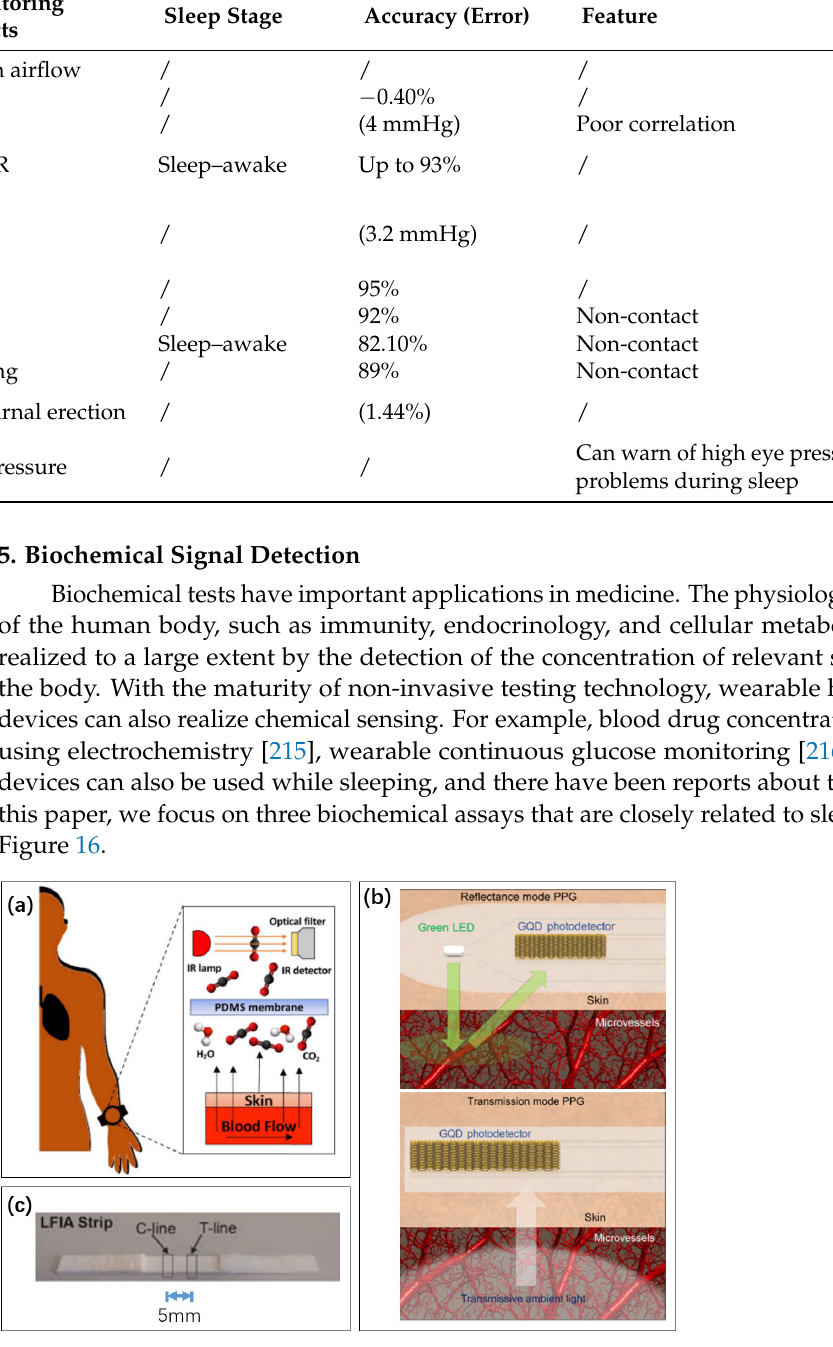
Figure 16. Examples of three biochemical detection methods in this section. ( a ) The concentration of carbon dioxide through the skin is detected by a gas sensor [218]. Reproduced under the terms of